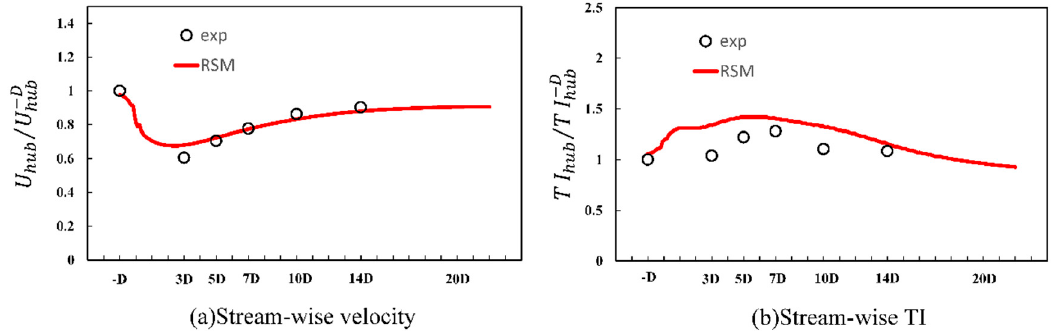
Figure 18. Recovery of the wake (at hub height), ( a ) stream ‐ wise velocity; ( b ) stream ‐ wise TI.